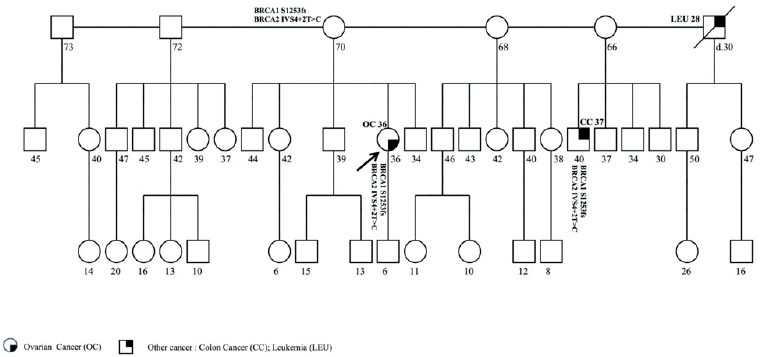
Figure 2. Pedigree of family 2 carrying the DH in BRCA1 c.3752_3755GTCT (p.Ser1253fs) and BRCA2